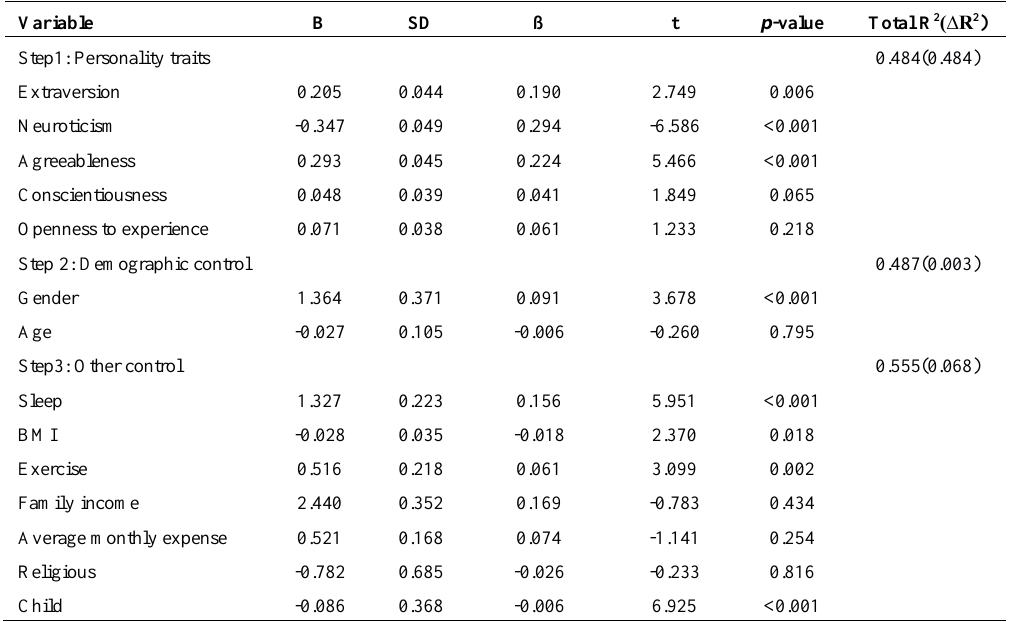
Table 3. Hierarchical regression analysis for predicting subjective